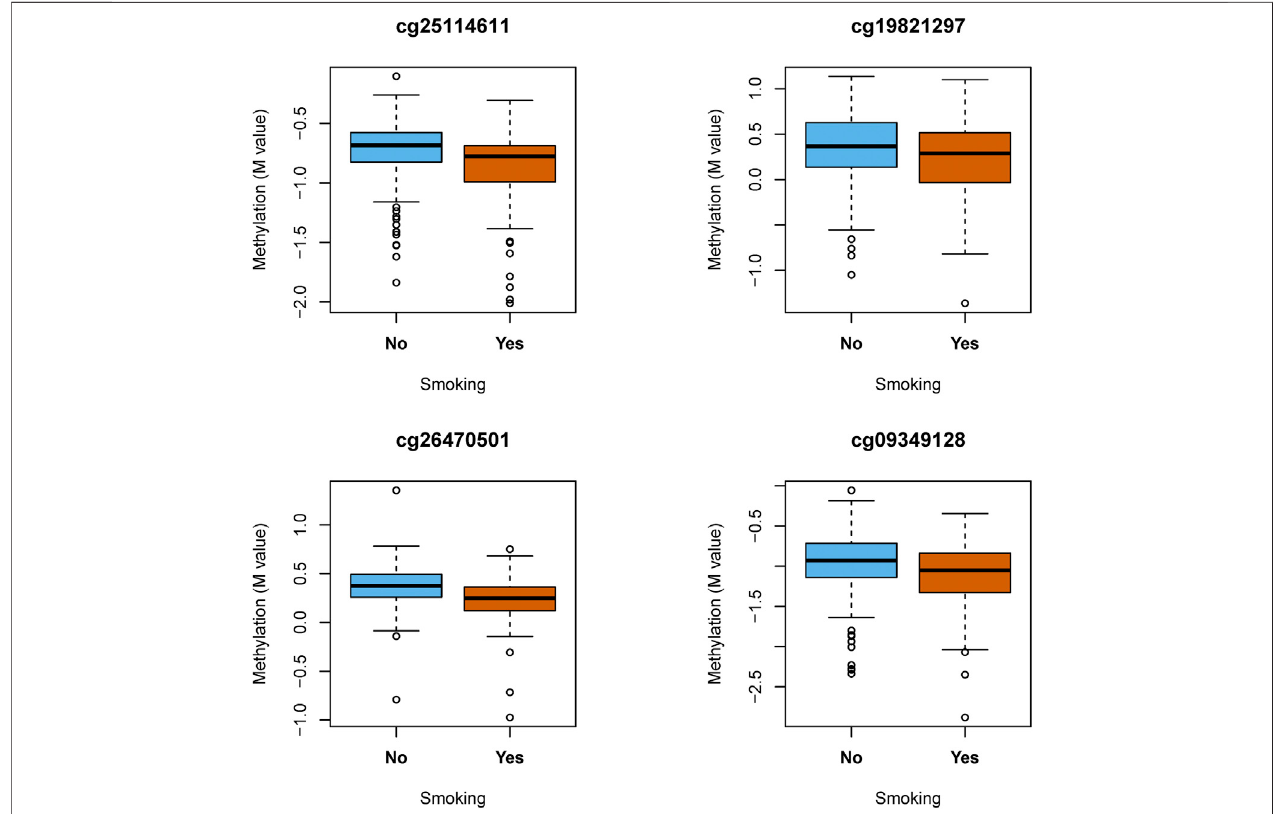
FIGURE 2 | DNA methylation level of the signi fi cant CpG mediators by smoking status.